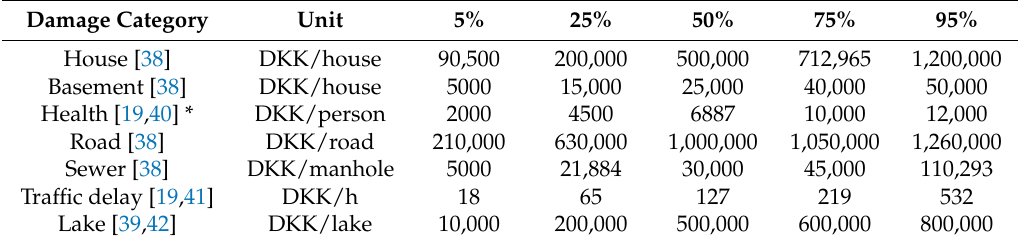
Table 2. Uncertainty ranges for stage-damage relationships for each item that can be damaged.